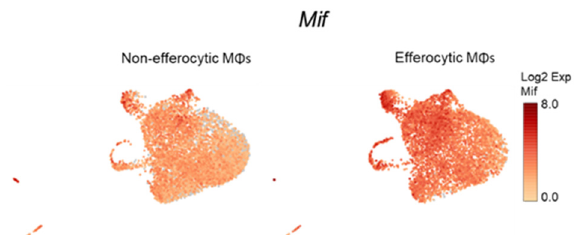
Figure A5. Single-cell plots of Mif expression in efferocytic BM macrophages. scRNA-Seq analysis plots show Mif distribution in efferocytic and non-efferocytic (control) clusters of BM macrophages (M Φ ) corresponding to Experiment 1 in Figure 1B.